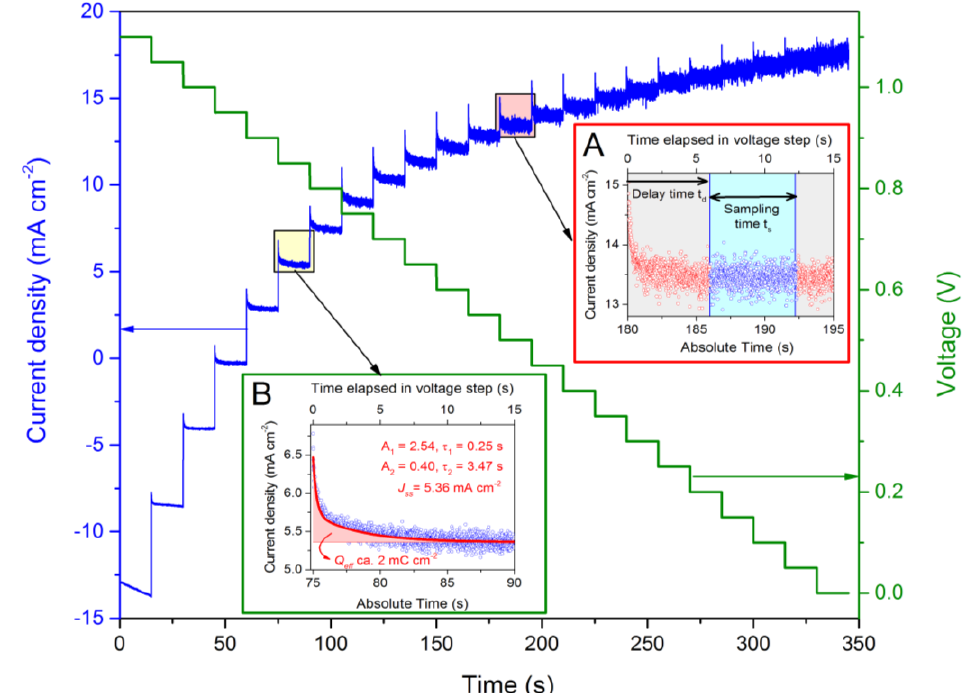
Figure 1. Transient current-density (left axis) response as a function of time (x-axis) in response to a staircase voltage sweep (right axis) from 1.1 V to 0 V (reverse scan direction). The current density exhibits visible overshoots followed by a slow decay in each voltage segment. Inset ( A ) highlights that both the delay time t d and sampling time t s influence the current recorded during a regular I ( V ) measurement. Inset ( B ) illustrates the possibility to analyze each individual voltage segment to extract characteristic time constants , ( τ 1 and τ 2 ), pre-exponential factors (A 1 and A 2 ), the steady state current ( J ss ) and integrated current density yielding the effective displacement charge density ( Q eff